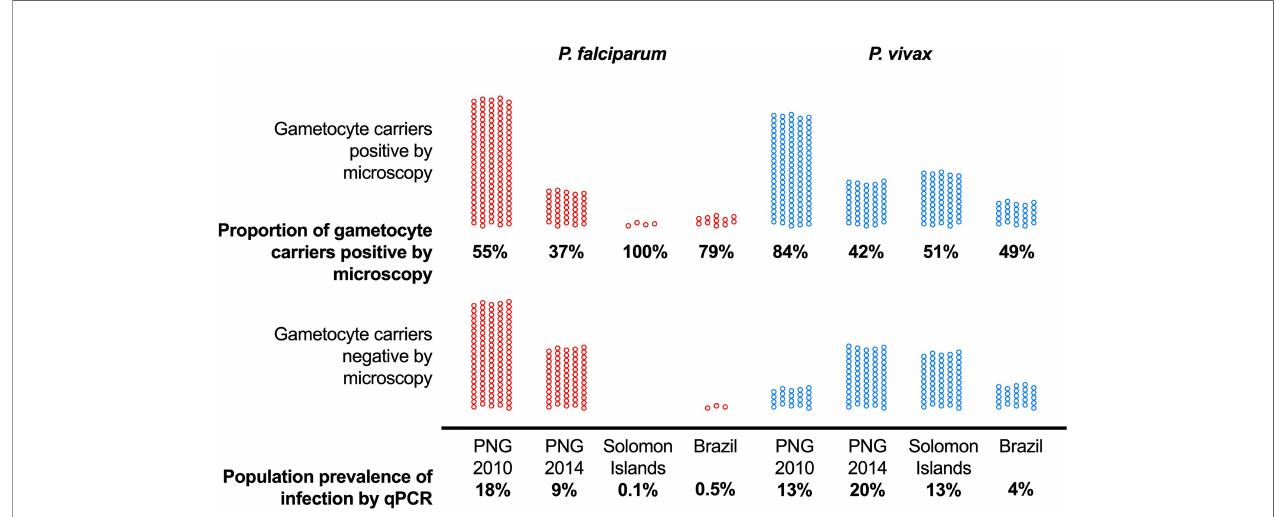
FIGURE 1 | The proportion of asymptomatic P. falciparum and P. vivax infections with gametocytes (detected by RT-qPCR) that can be detected by microscopy differs among sites with different transmission intensity. Data from 10,111 surveyed individuals included. Population prevalence of infection by qPCR is indicated at the bottom and ranged from 0.1% to 18% for P. falciparum and 4% to 20% for P. vivax . Among all P. falciparum gametocyte carriers, 37% to 100% could be identi fi ed by microscopy, and 42% to 84% of P. vivax gametocyte carriers. PNG, Papua New Guinea. Data from (Waltmann et al., 2015; Koep fl i et al., 2017; Almeida et al., 2018; Koep fl i et al.,